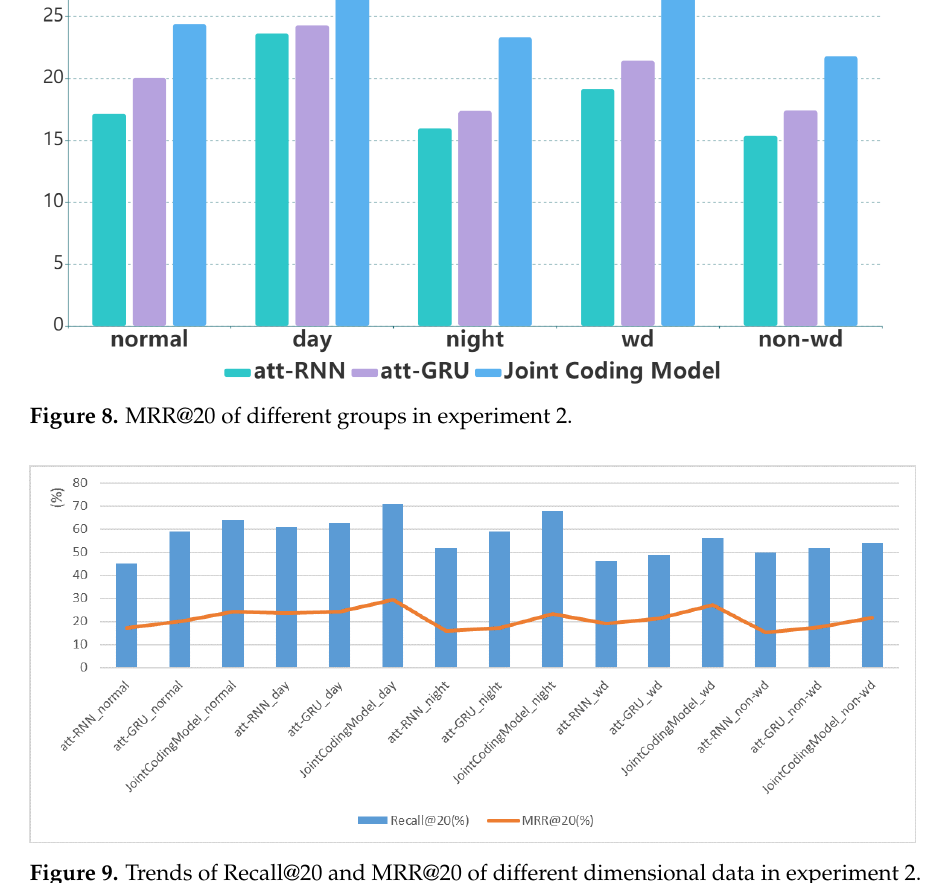
Figure 9. Trends of Recall@20 and MRR@20 of different dimensional data in experiment